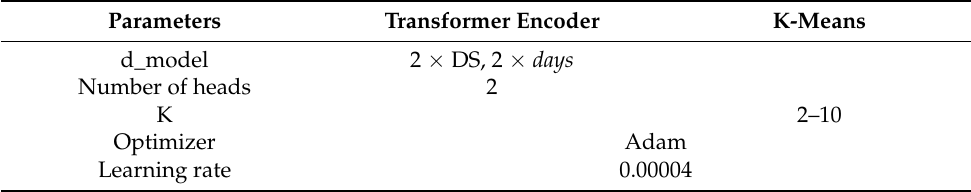
Table 2. Parameters used in the classification block. Parameters